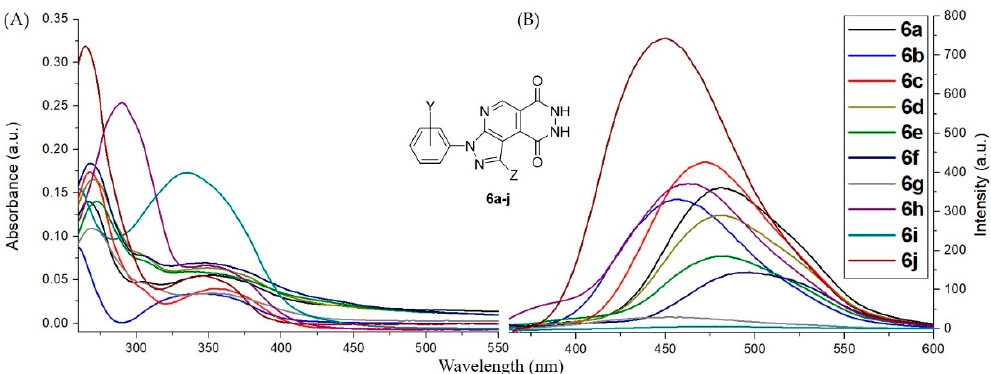
Figure 5. Photoluminescence spectra of pyrazolopyridopyridazine diones 6a – j dissolved in DMSO to prepare a stock solution (1.0 mM). Then the stock solutions were diluted with CH 2 Cl 2 to a concentration of 10 μ M. ( A ) Absorption and ( B ) emission spectra of compounds 6a – j .